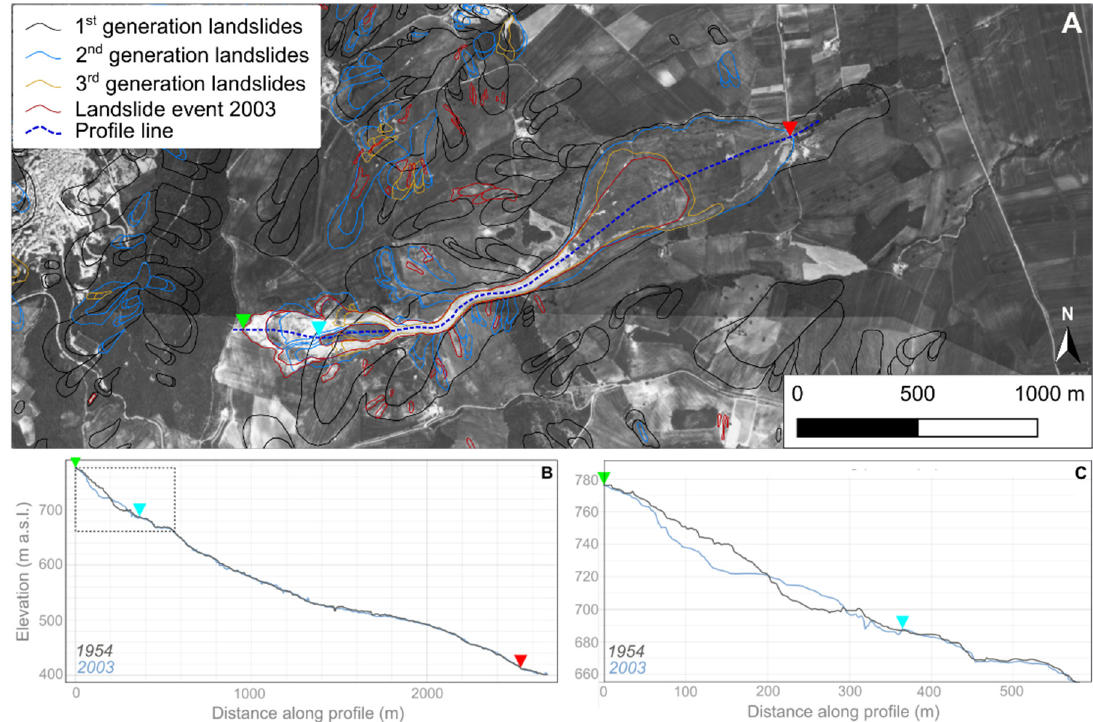
Figure 6. (A) Location of the longitudinal profile of the 2003 landslide event. Coloured triangles mark location or reference in the profiles. Base map: orthophoto obtained by the automatic pipeline from the photographs acquired in 2003. (B) Comparison of the topographic profiles obtained for the acquisition of 1954 (dark grey line) and 2003 (light blue line). Dotted box delimitates the detail in C. (C) Detail of the comparison in